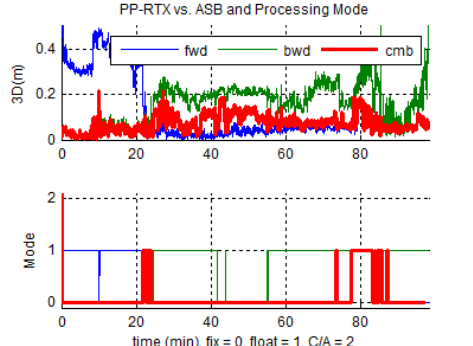
Figure 12: Forward, Backward & Combined PP-RTX vs. ASB